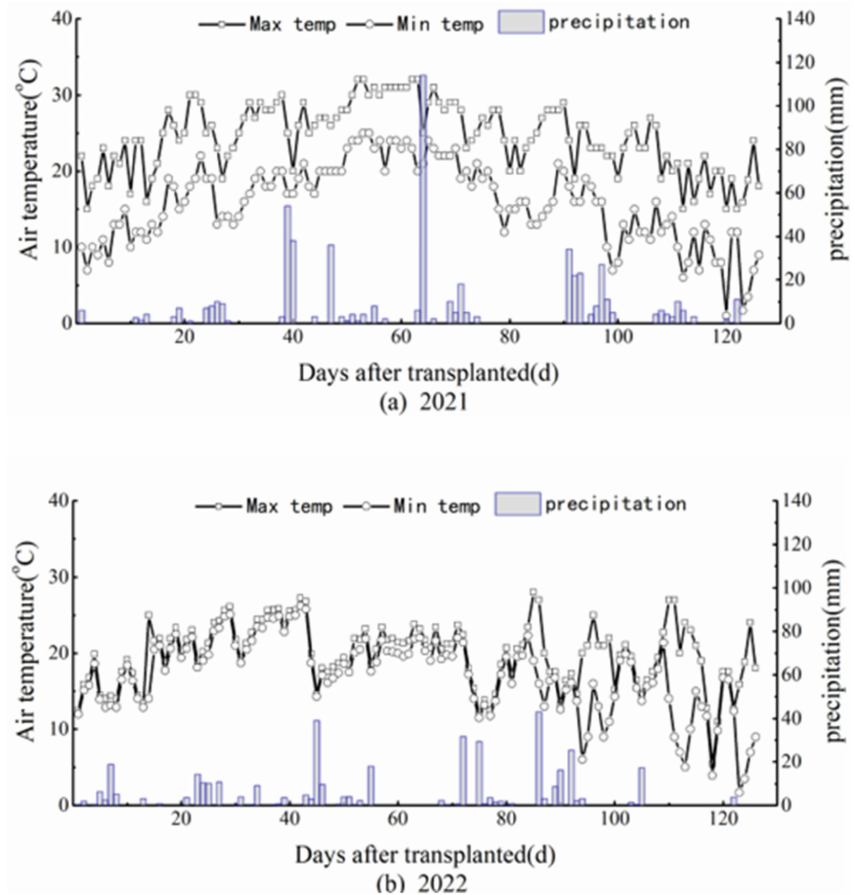
Figure 2. Changes of air temperature and precipitation in ( a ) 2021 and ( b )